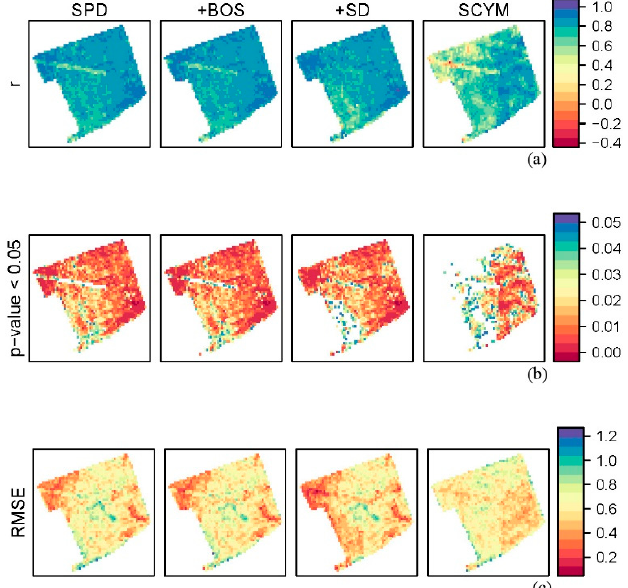
Figure 8. For field M, the correlation between actual and estimated yields at each pixel for all the years using each of the four models: Statistical phenology detection (SPD), statistical phenology detection incorporates sowing date (+SD), statistical phenology detection incorporates break of season (+BOS) and scalable crop yield mapper (SCYM). ( a ) r; ( b ) p -value < 0.05; ( c ) RMSE.